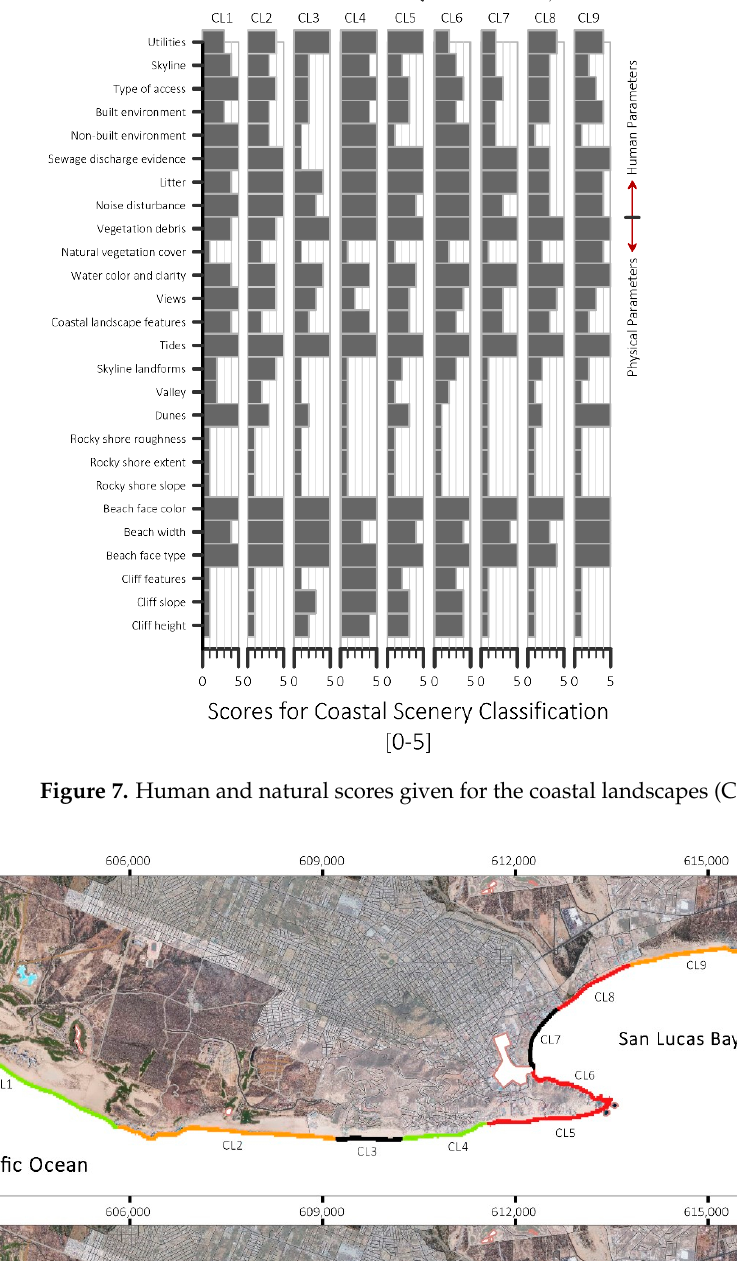
Figure 8. Maps of the study area, showing ( a ) Scenery Classification (Sc. Cl.) according to Table 1 and ( b ) Coastal Vulnerability Index (CVI).